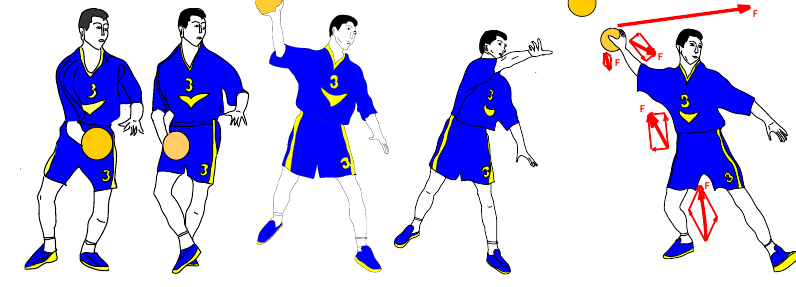
Fig.2. Fragments of educational cartoon: rules of forces addition by vectors when throwing [7]